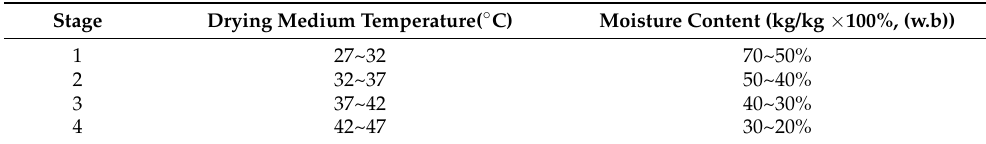
Table 2. Drying process and parameters of dried grass